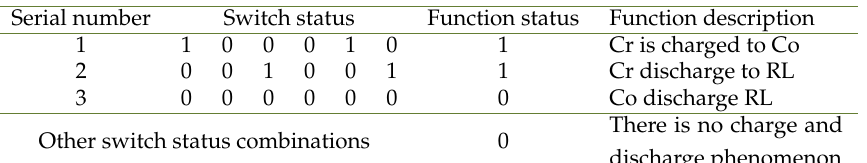
Table 3. Expected functional status